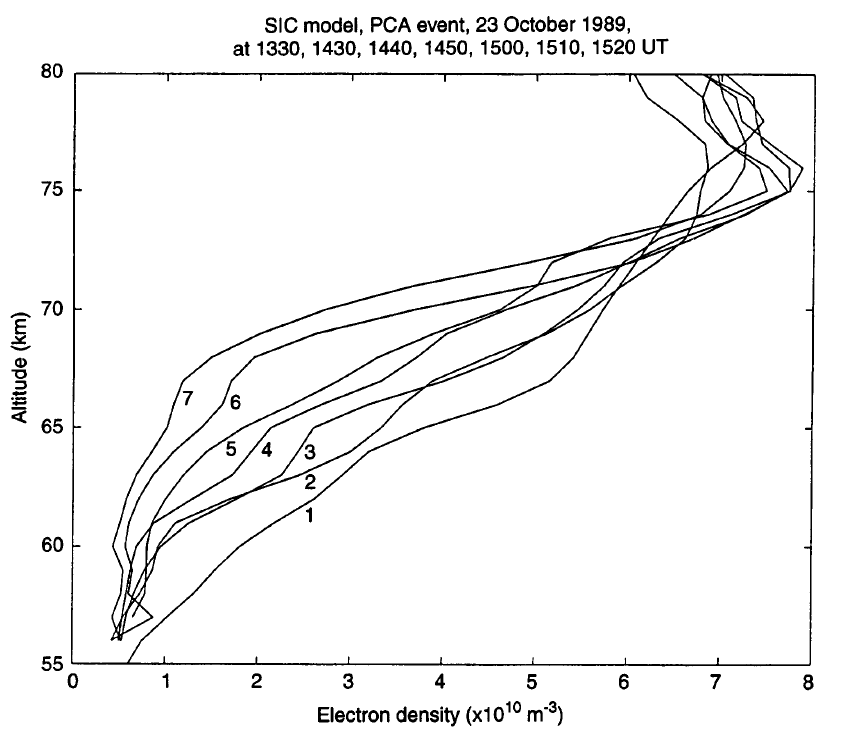
Fig. 4. Electron densities (in m (cid:255) 3 ) after cor- rection of the Debye length, and the negative ion-ratio dependences on the ‘raw’ density profiles (shown in Fig. 1). The resulting profiles have been smoothed over 2 km